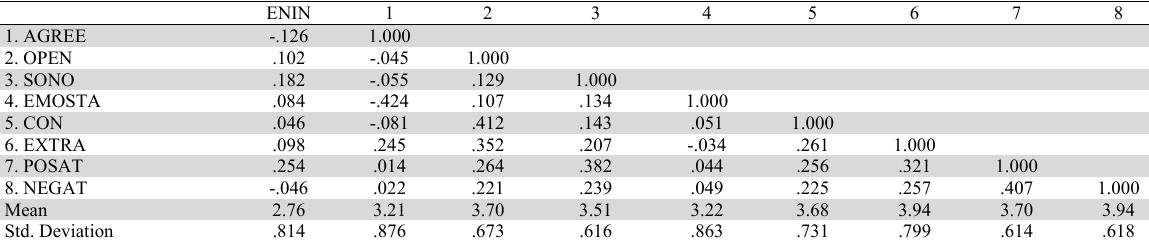
Pearson’s Correlation Coefficients between Variables and ENIN